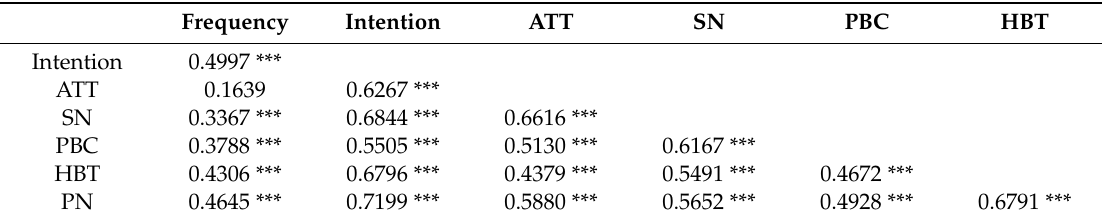
Table A6. Correlation between TPB constructs, perceived need, and habit for fruit consumption ( n = 78). Frequency Intention ATT SN PBC HBT